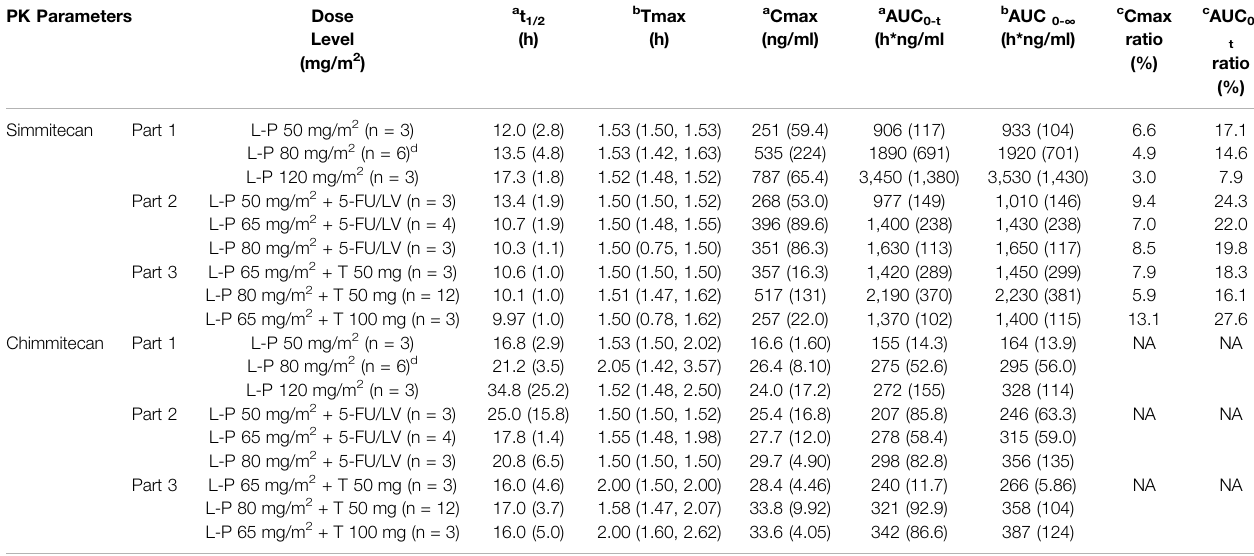
TABLE 5 | Pharmacokinetic parameters of simmitecan and chimmitecan. PK